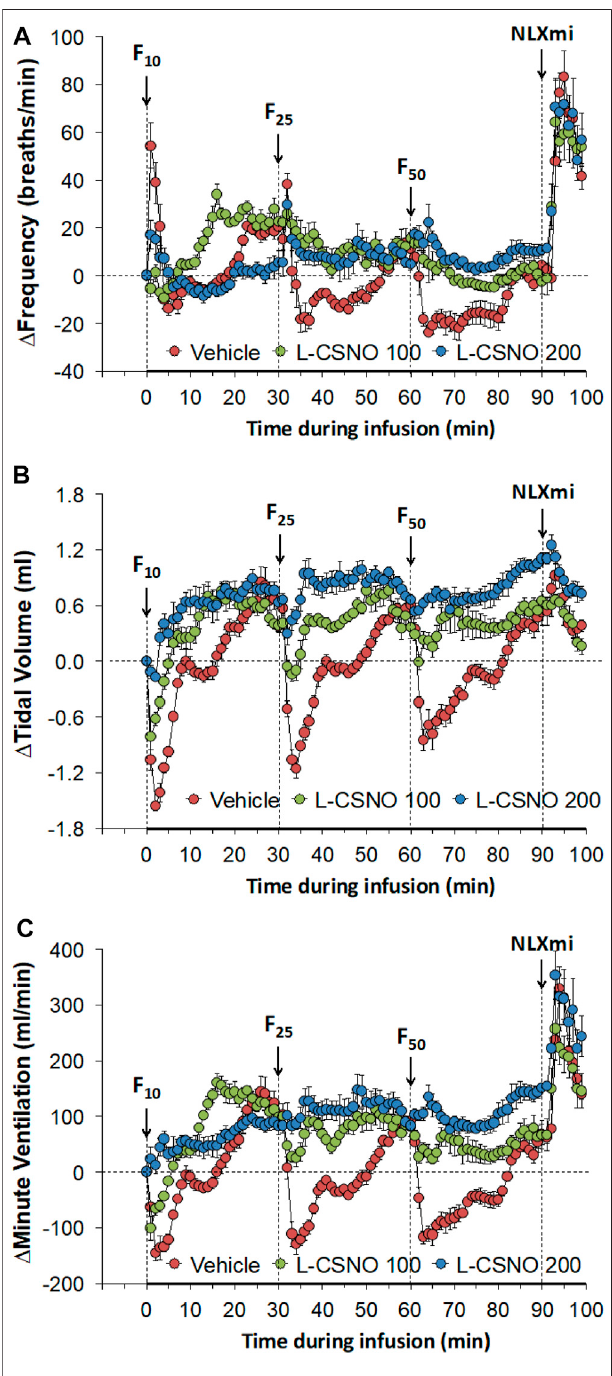
FIGURE 2 | Arithmetic changes in baseline frequency of breathing (A) , tidal volume (B) and minute ventilation (C) elicited by bolus injections of fentanyl at F10 (10 μ g/kg, IV), F25 (25 μ g/kg, IV), and F50 (50 μ g/kg, IV) in rats receiving continuous infusion of vehicle (20 μ l/min, IV), L-CSNO 100 (S-nitroso-L-cysteine, 100 nmol/kg/min, IV) or L-CSNO 200 (S-nitroso-L-cysteine, 200 nmol/kg/min, IV). A bolus injection of naloxone methiodide (NLXmi (2.5 mg/kg, IV) was given at the 90 min timepoint. The data are presented as mean ± SEM. There were 8 rats in each